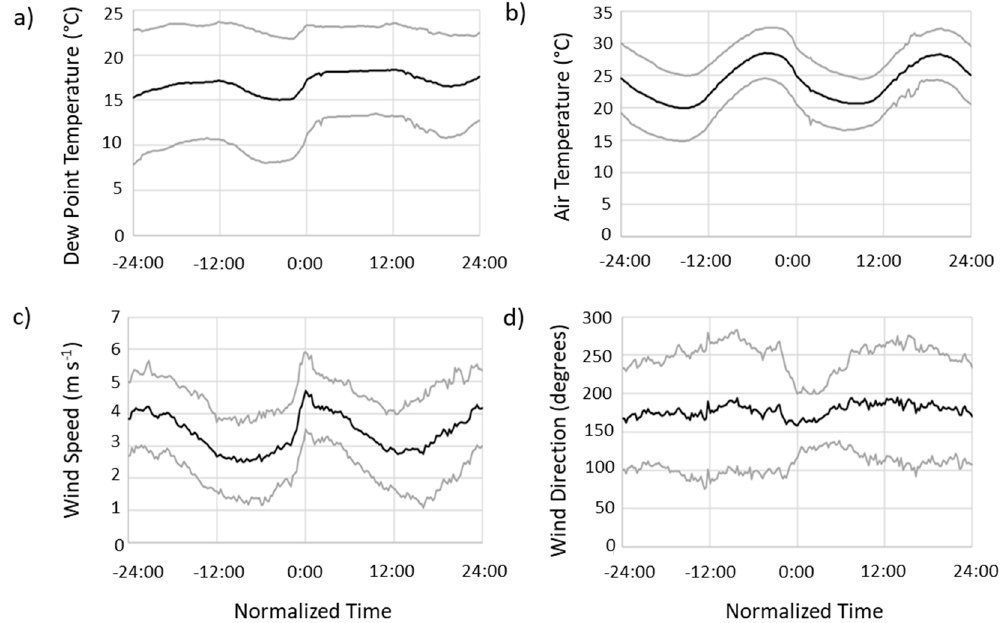
Figure 4. Average (thick) and one standard deviation above and below for ( a ) dew point temperature, ( b ) temperature, ( c ) wind speed and ( d ) wind direction for sea breeze cases at MT1, including the 24 h prior to and after the time of sea breeze passage at MT1. Times have been normalized to ensure that the time of the sea breeze passage is adjusted to be 0:00 in the center of the plots.